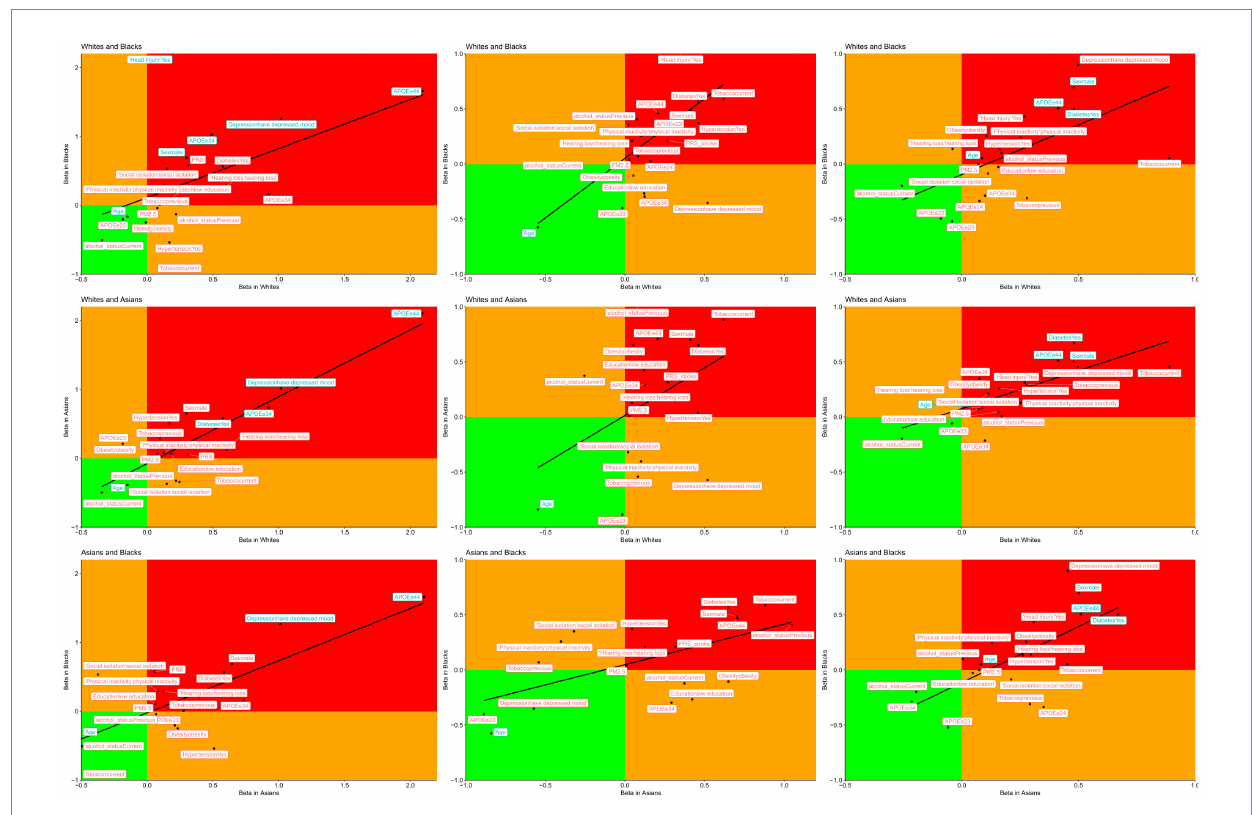
FIGURE 2 Correlations between risk factors of dementia (left columns), stroke (middle columns) and mortality (right columns) by ethnicity, blue colour indicates the variables found to be significantly different between the two ethnicities.